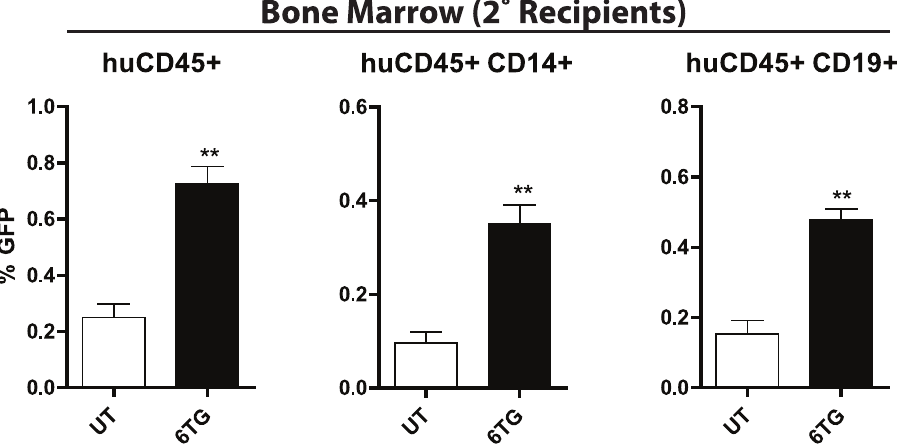
Figure 5. Knockdown of HPRT allows for selection from primitive HPC in vivo. Bone marrow cells from primary recipients of sh491G transduced human UCB cells were transplanted into sub-lethally irradiated secondary recipients. After 3 weeks, secondary recipients were left untreated (UT) or treated with 6TG. Six weeks later, tissues were harvested for analysis by flow cytometry. The percentages of GFP + human leukocytes (huCD45 + ), and B-lymphocyte (huCD45 + CD19 + ) and myeloid (huCD45 + CD14 + ) sub-populations in the bone marrow are depicted. There were 3 mice per group in this experiment.